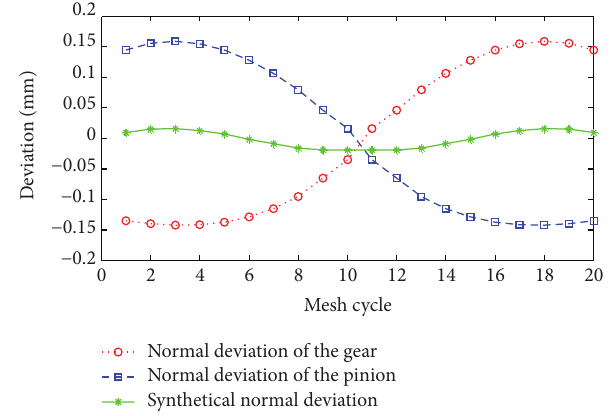
Figure 6: The normal profile deviation of microsegment gear com- pared with standard involute